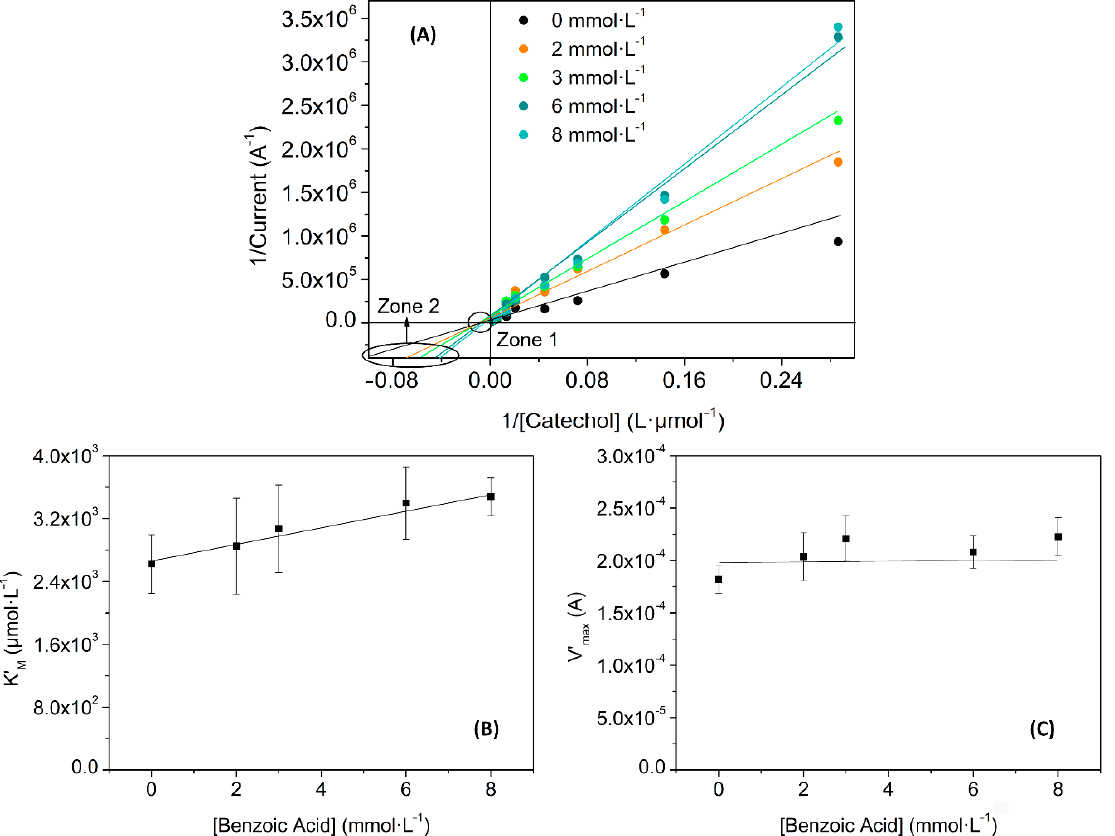
Figure 10. Biosensors kinetic study, ( A ) Lineweaver–Burk linearization for four benzoic acid concentrations; ( B ) represen- tation of the obtained K’ M values for each inhibitor concentration; and ( C ) V’ max obtained values for each inhibitor concen- tration.